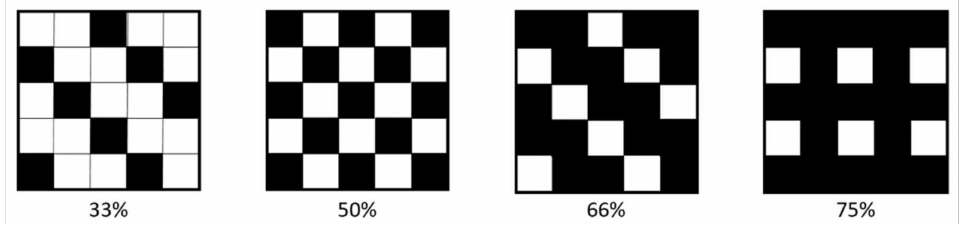
Figure 10. Selectable coverage percentages and their